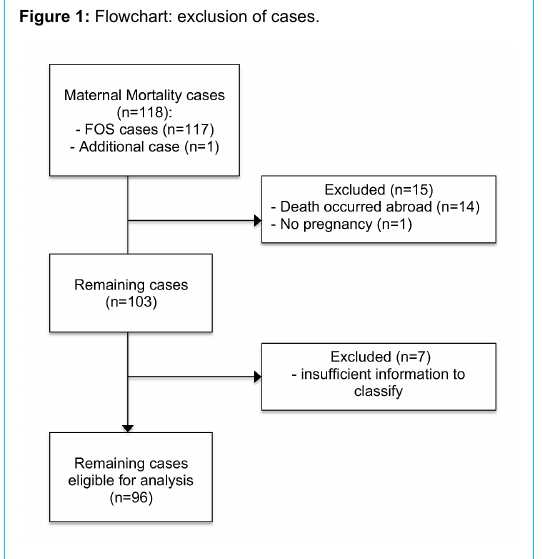
Figure 1: Flowchart: exclusion of cases.